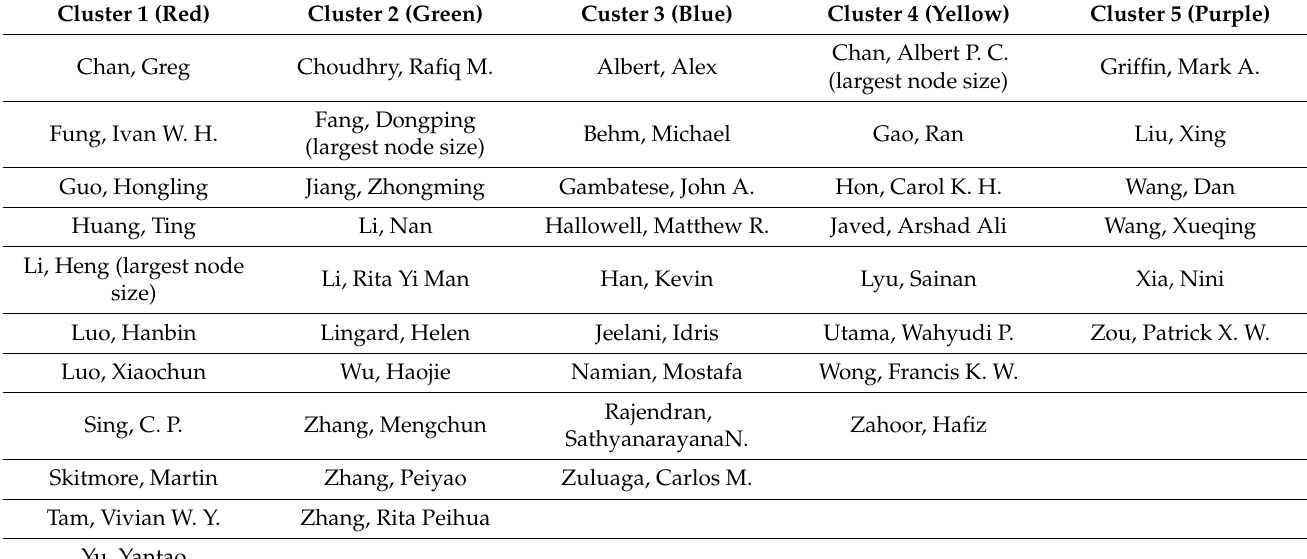
Table 1. Cluster classification of